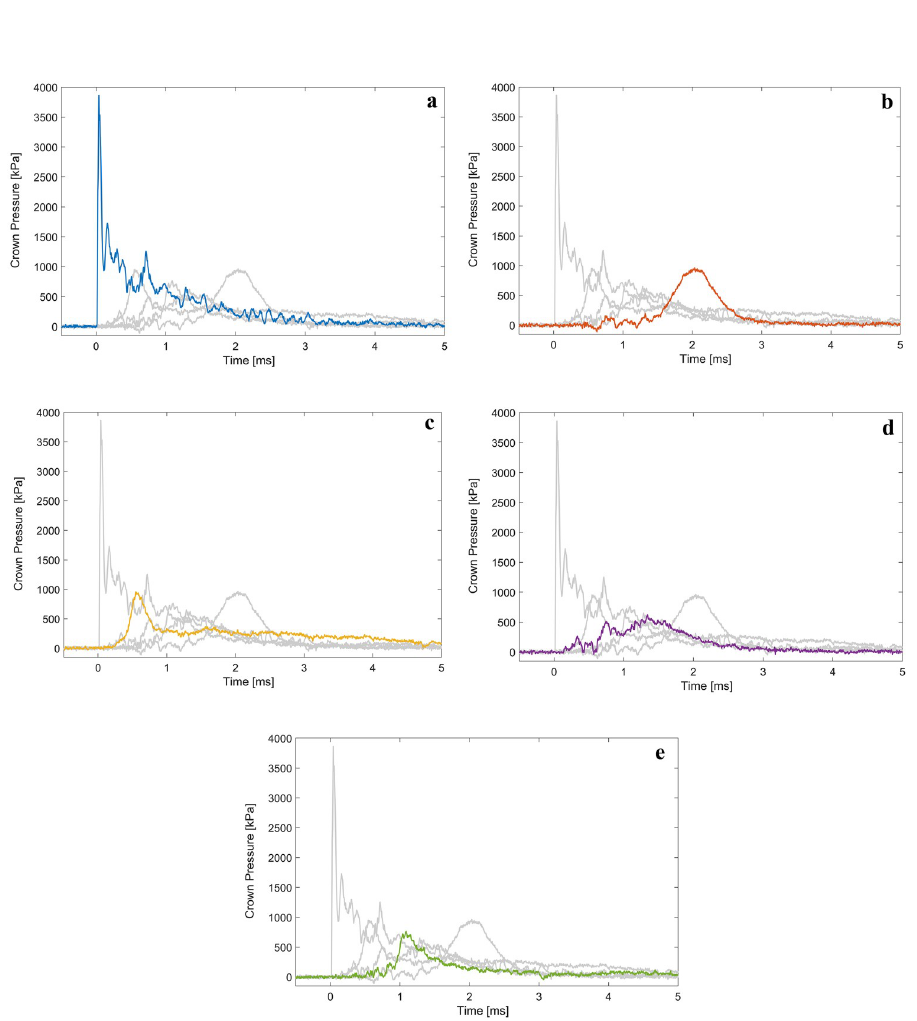
Fig 5. Representative pressure traces. Measured at the crown of the dummy head, for 12 membrane (3.048 mm PET) tests of the (a) Bare Head, (b) Advanced Combat Helmet, (c) Brodie Helmet, (d) Adrian Helmet, and (e) Stahlhelm.